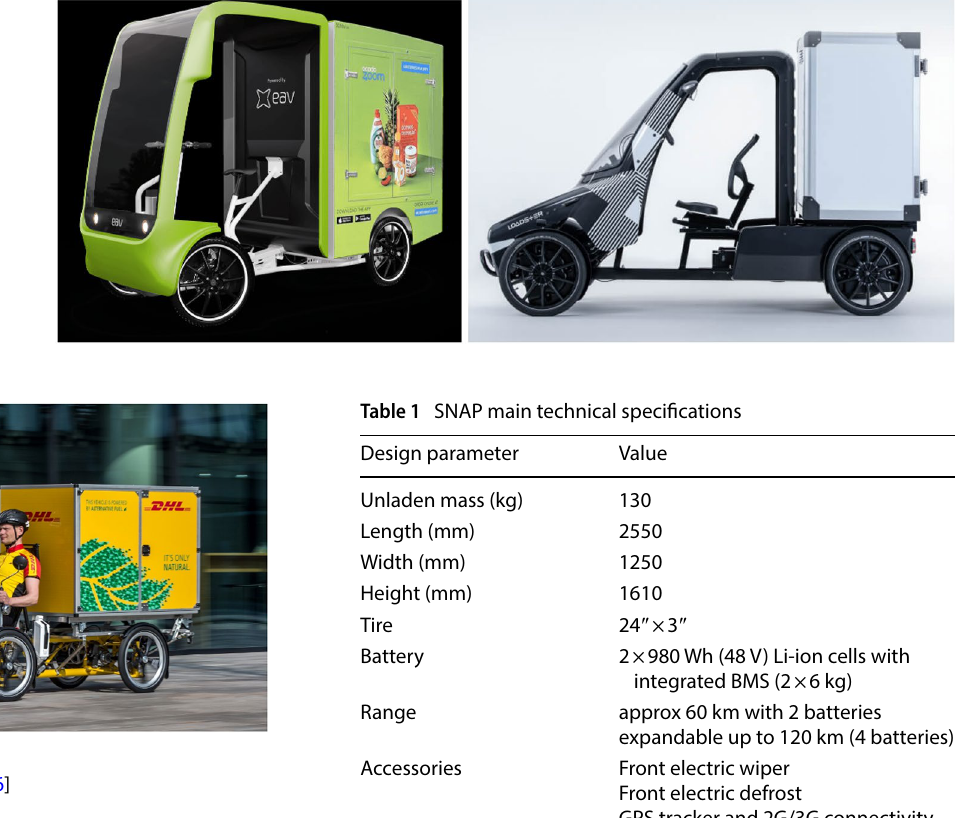
Fig. 3 The EAV vehicle [14] (left), and the CITKAR vehicle [15] (right)